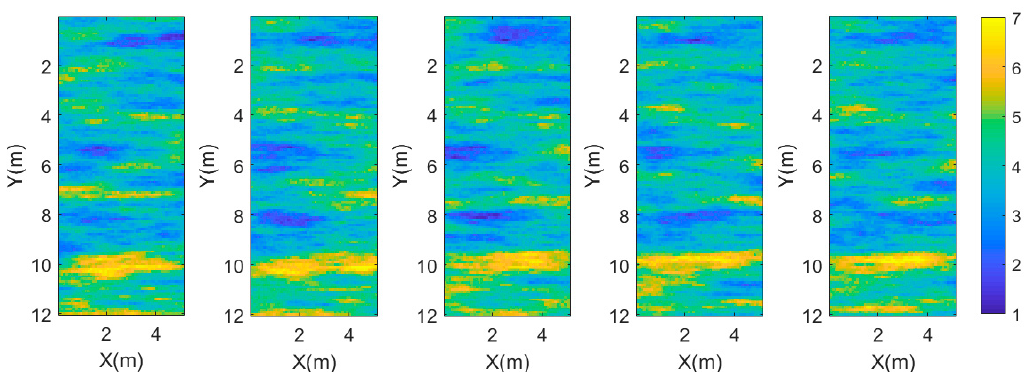
Figure 6. Five inversion models of the posterior probability density.